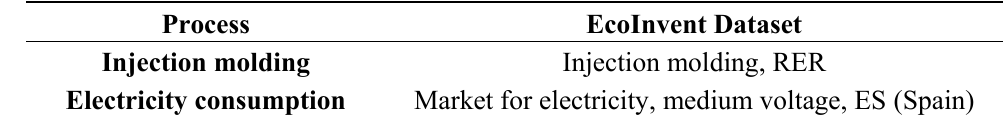
Table 3. Process